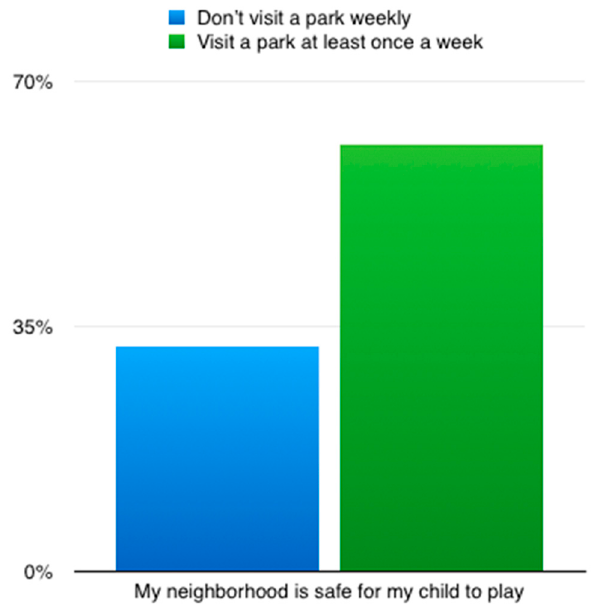
Figure 2. Frequency of those who have no park visits per week and those who have at least one park visit per week amongst those who believe their neighborhood is safe for children to play.